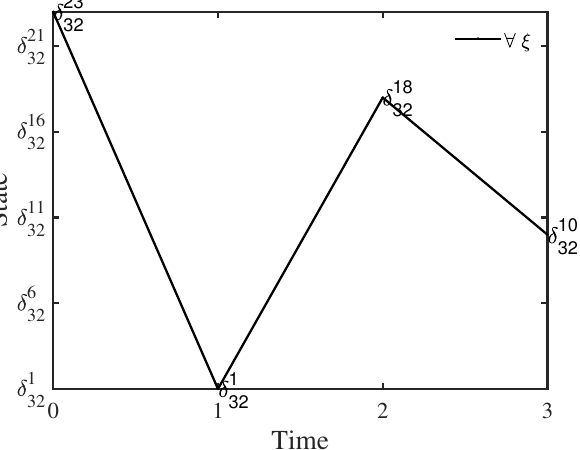
Figure 6. Evolutionary trajectories of initial state δ 23